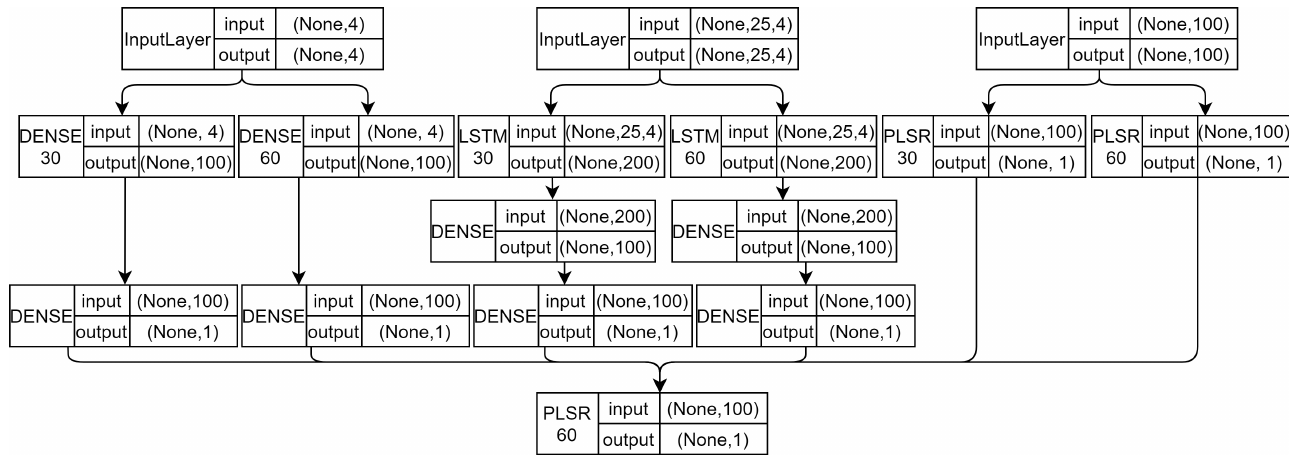
Figure A11. Khadem’s architecture block